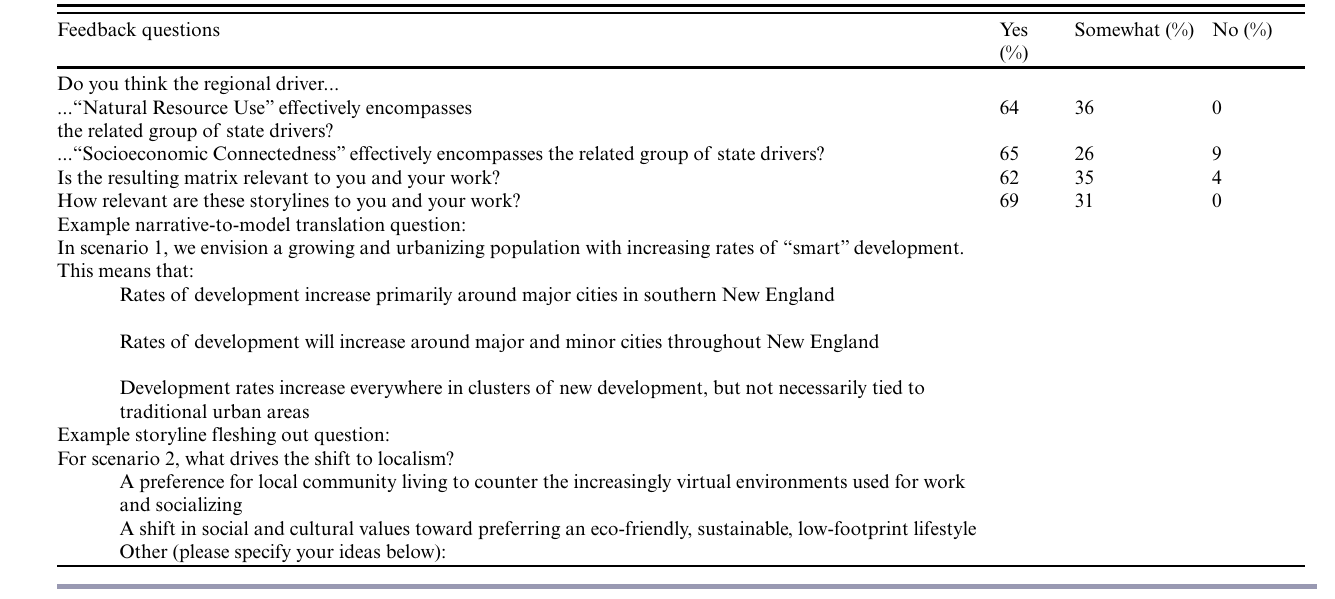
Table 6 . Stakeholder feedback solicited during the webinars (n =